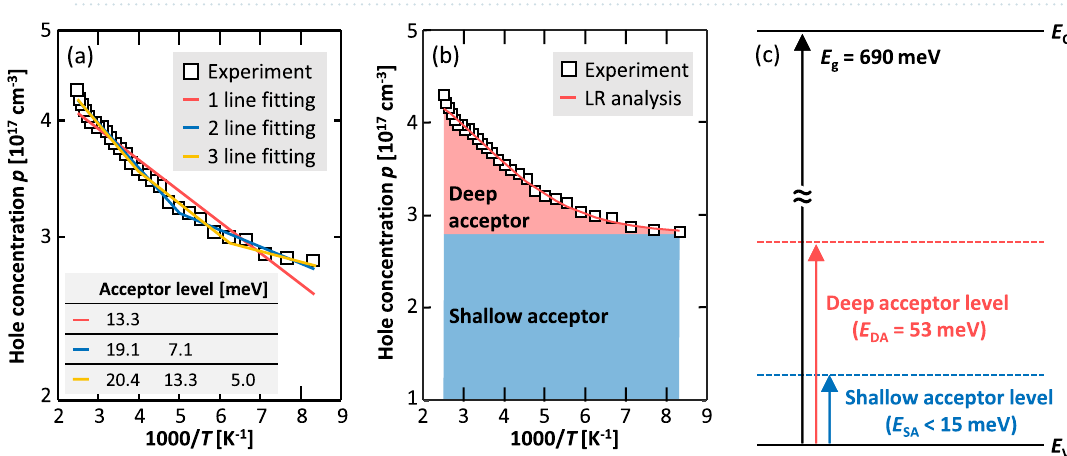
Figure 3. Electrical properties of the Ge layers as a function of T d before and after PA. ( a ) p and ( b ) μ , which were averaged over four measurements for each sample. ( c ) Arrhenius plots of μT of the samples for T d = 50 and 125 °C before PA; here, the dotted lines are the fitted lines used to derive E B . ( d ) E B of GBs as a function of T d .